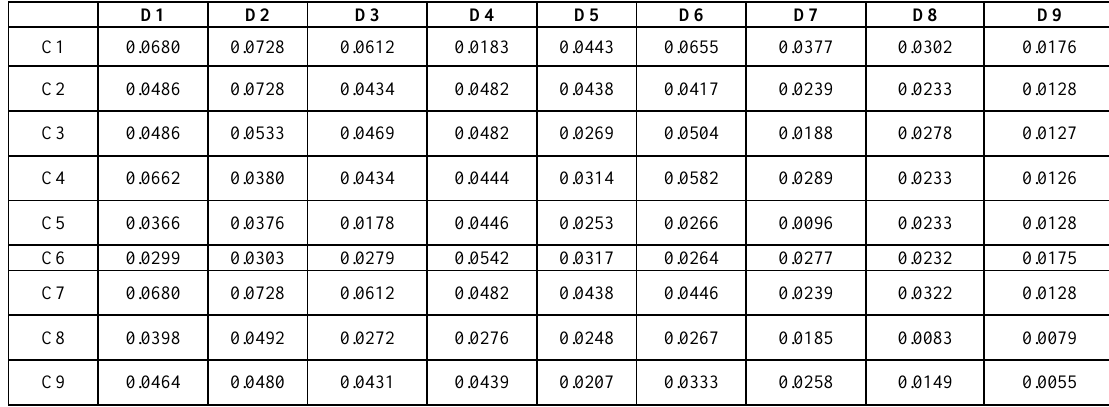
Table 5. Weighted normalized decision